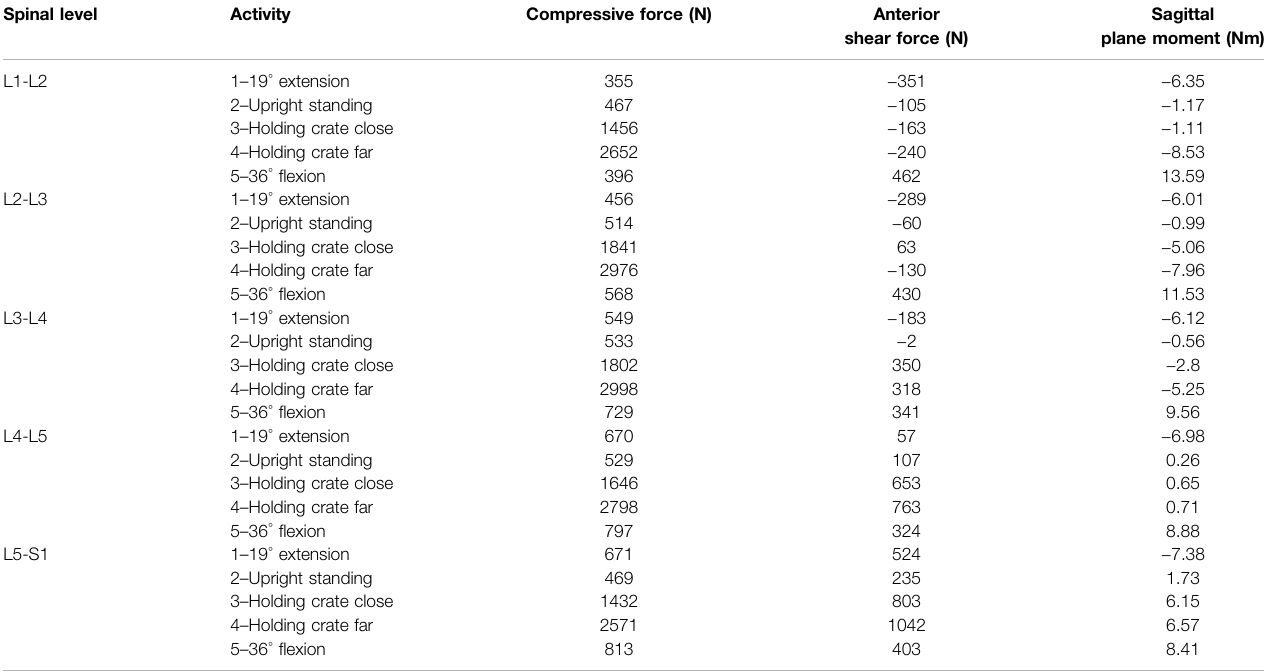
TABLE 1| Predictedcompressiveforces,shearforces,andsagittalplanemoments atallvertebral levelsbythemodelforthe fi vedifferentactivitiesperformedbythesubject of the in vivo study (Wilke et al., 2001).